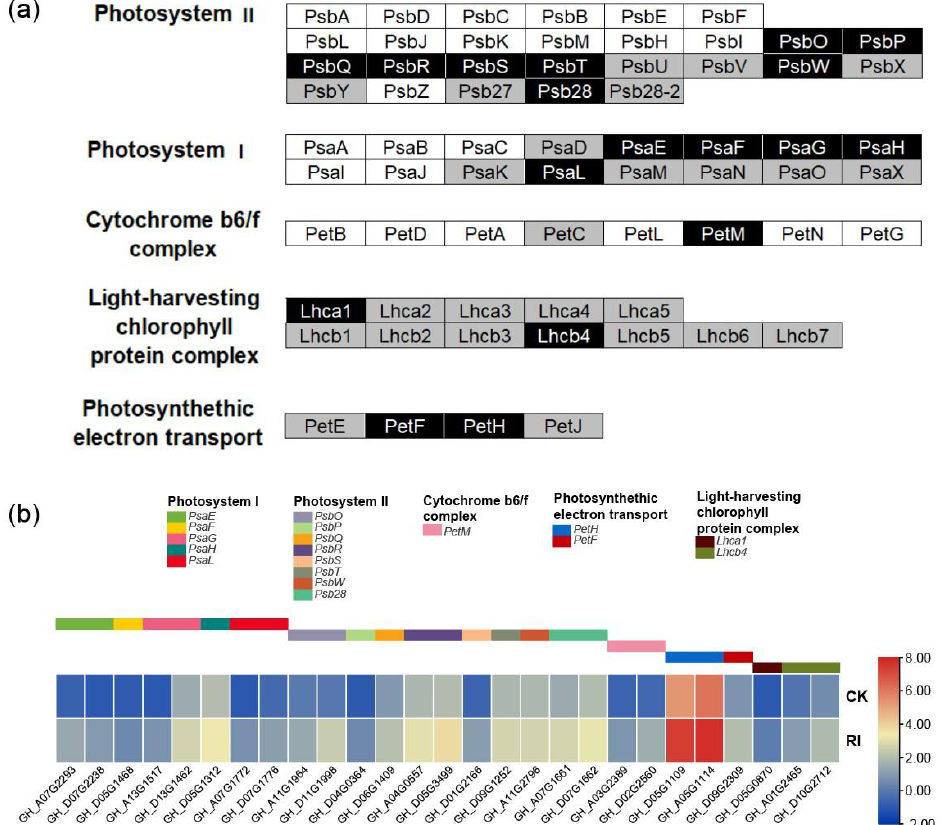
Figure 4. The significantly upregulated photosynthesis genes under root illumination. ( a ) the genes participating in photosynthesis pathway including photosystem I, photosystem II, cytochrome b6/f complex, light-harvesting chlorophyll protein complex (LHC) and photosynthetic electron transport, the dark boxes represent the significantly upregulated nuclear-encoded genes under RI (padj <